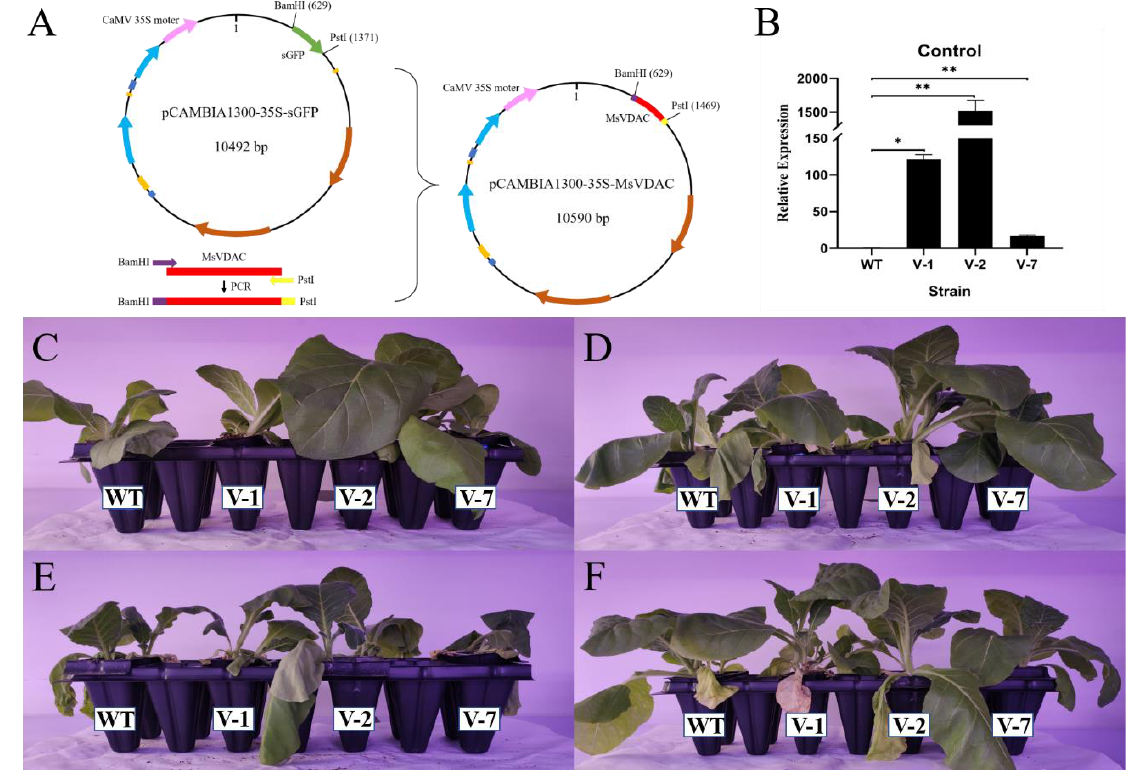
Figure 3. ( A ) Construction of the pCAMBIA1300-35S::MsVDAC recombinant vector; ( B ) Expression level of MsVDAC in transgenic tobacco (T2 generation) and WT plants according to qPCR analysis; ( C – F ) Phenotypes of transgenic tobacco and WT plants under normal conditions and cold, drought, and salt stress, respectively. WT: wild type. V-1: line 1. V-2: line 2. V-7: line 7. *, p < 0.05. **, p < 0.01.